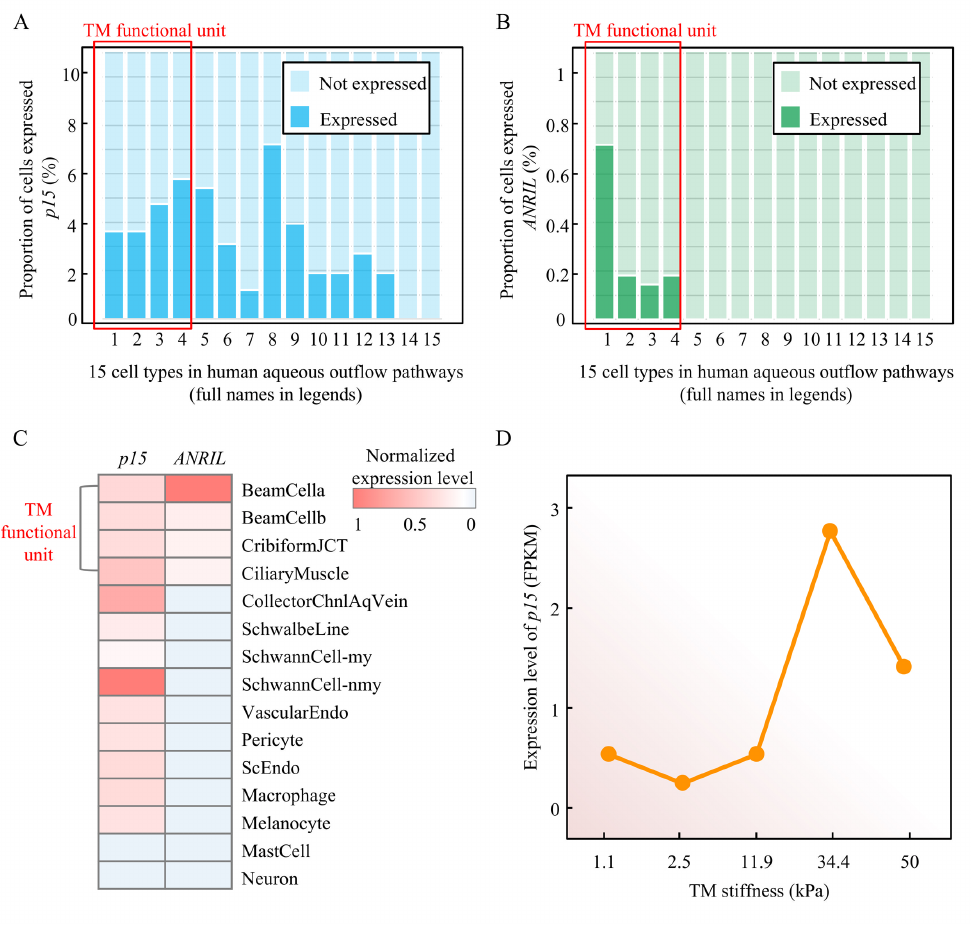
Figure 7. The ANRIL/p15 expression in human TM cells and its relationship with TM stiffness. ( A ) The proportion of p15-expressed cells in each cell type in human aqueous outflow pathways. From left to right: 1 beam cells A, 2 beam cells B, 3 juxtacanalicular tissue cells, 4 ciliary